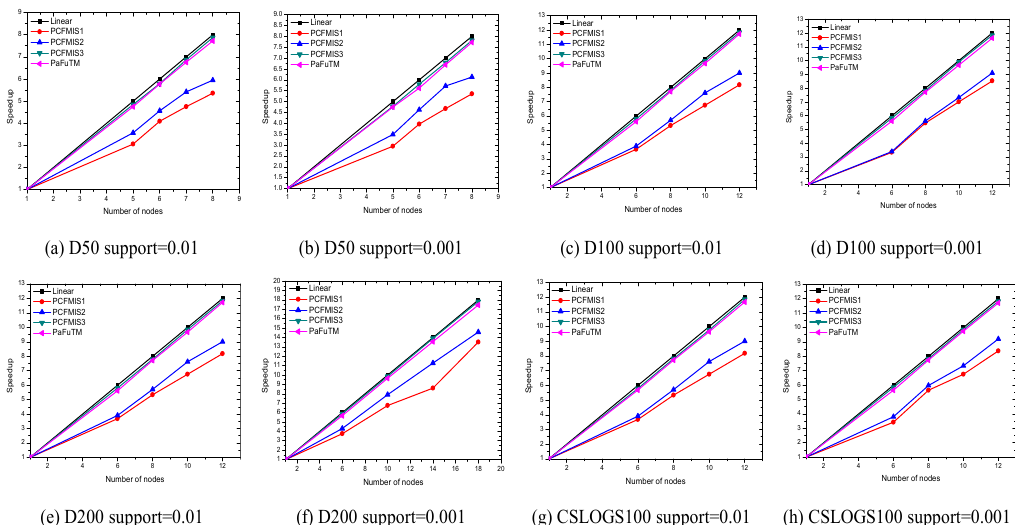
Figure 8. The speedups of four algorithms for four data sets on a large number of